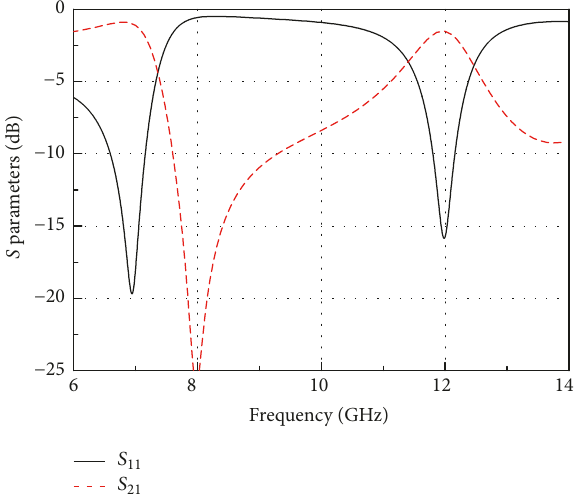
Figure 8: Simulated 𝑆 parameters of the proposed